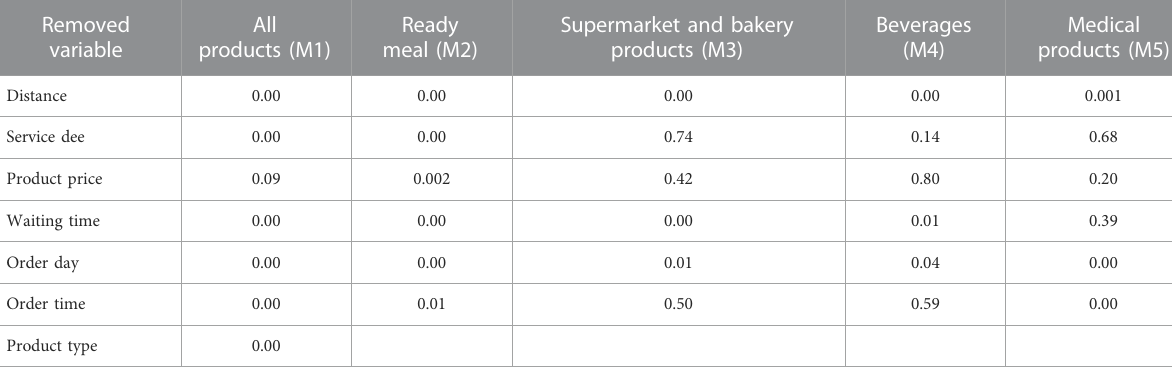
TABLE 3 p -value of the likelihood ratio